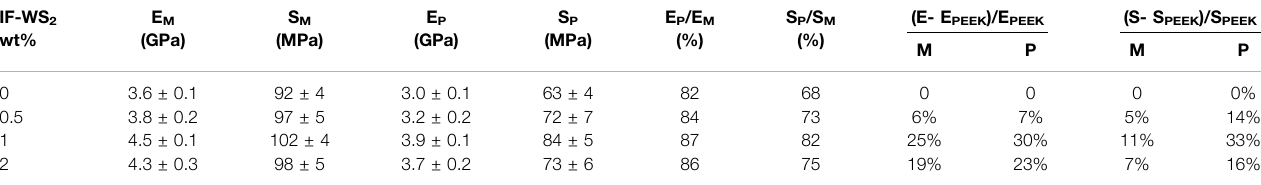
TABLE 1 | Comparison between the mechanical properties of injection moulded and 3D printed PEEK/IF-WS 2 nanocomposite samples. IF-WS 2 wt%